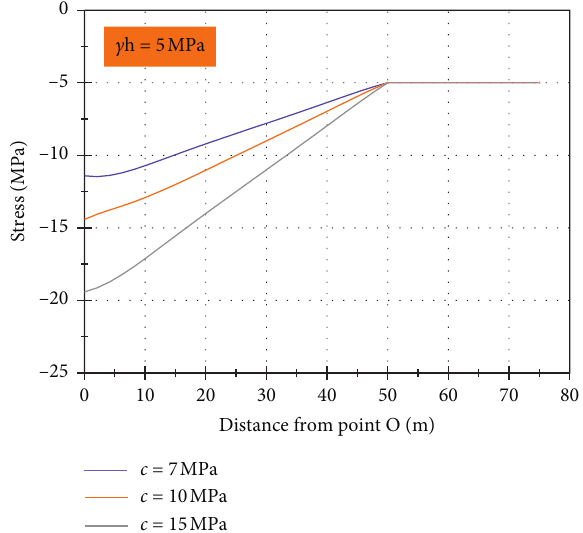
Figure 4: Change curves of nominal stress in a different parameter c